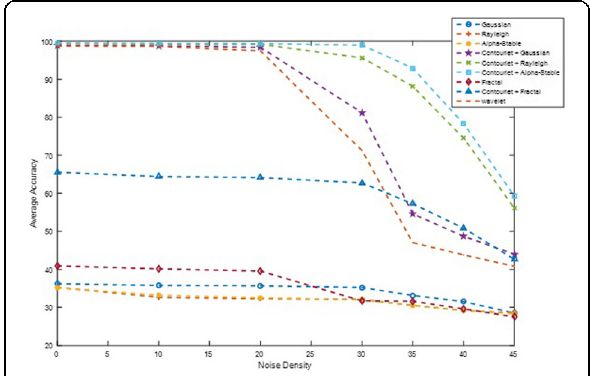
Fig. 23 Average segmentation accuracy of different methods in the presence of noise for Vistex